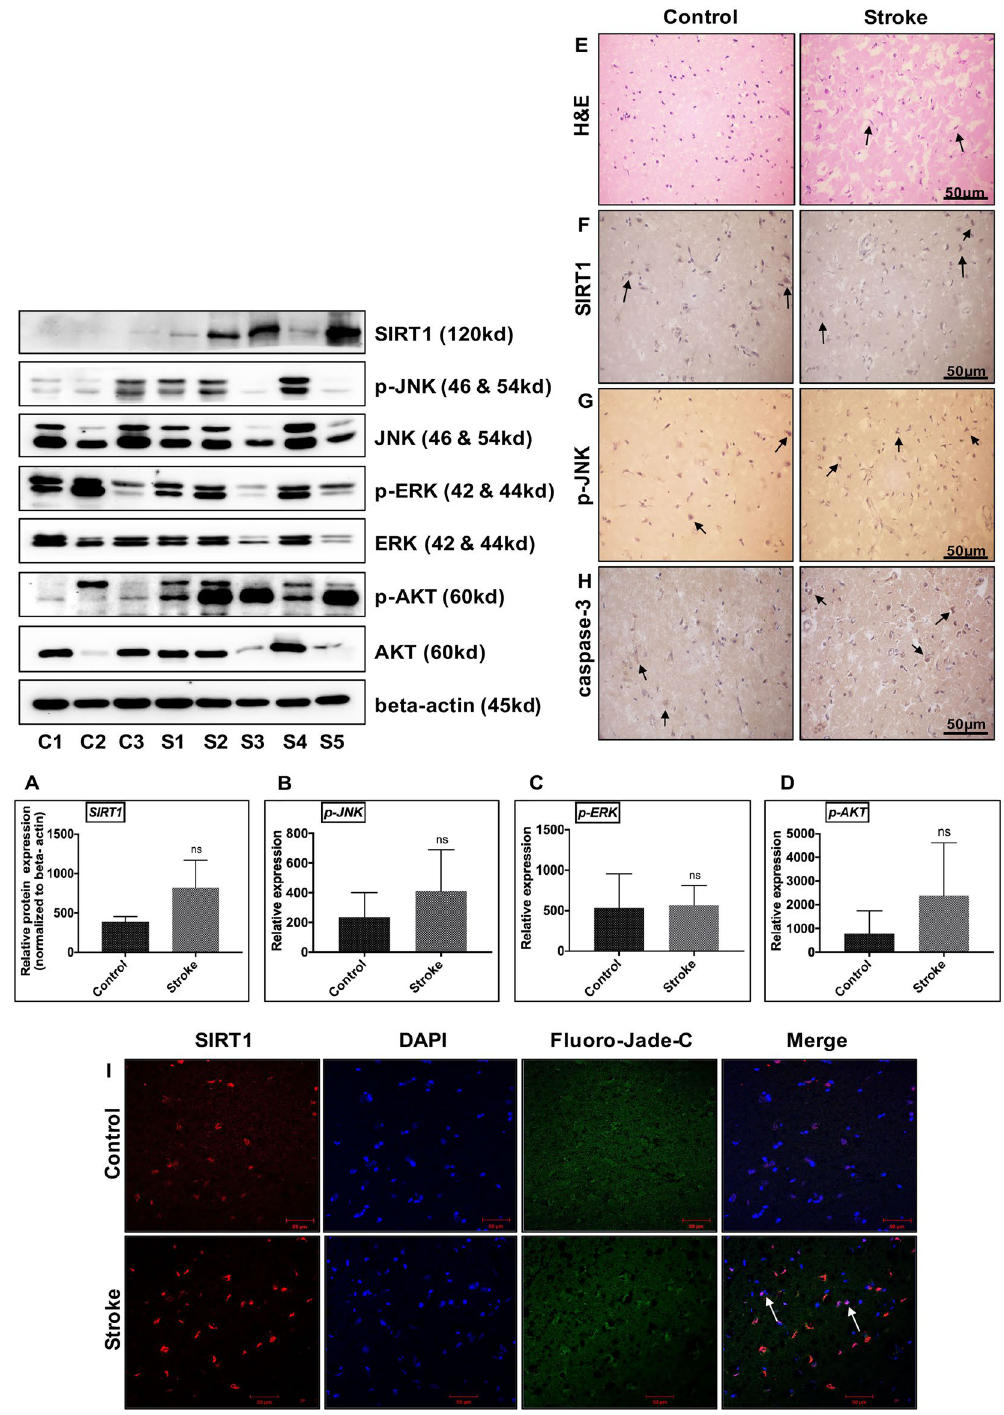
Figure 5. Effect of ischemia on the expression of SIRT1/JNK/ERK/AKT signaling pathway in Post-mortem human brain tissue. An equal amount of total protein sample (50 μg) from Control (n = 3) and Stroke brain (n = 5) were probed by western blots to analyze the expression of SIRT1 and phosphorylation status of p-JNK, p-ERK, and p-AKT. Respective total proteins and beta-actin were served as the loading control (p-JNK, p-ERK, and p-AKT), while SIRT1 was normalized to beta-actin. (A–D) represents an increase in SIRT1, p-JNK, p-ERK, and p-AKT protein expression in human stroke brain compared to respective healthy control. Data represented as mean ± SD. *p < 0.05 versus control brain. Human control (n = 3), as well as stroke brains (n = 4), were paraffin embedded and sectioned into 5-10 μm thick slices. (E) Histopathological changes were observed using H&E staining (magnification ×400; Scale Bar—50 μm). (F,G,H) immunoreactivity of SIRT1, p-JNK, and caspase-3 in control and stroke human brain. Black arrow represents changes in immunoreactivity from respective group. Hematoxylin counterstain used for visualization of neuron nucleus. Immunoreactivity for SIRT1, p-JNK, and caspase-3 was depicted in brown (DAB) (magnification ×400; Scale Bar—50 μm). (I) Triple immunofluorescence labeling was used to probe for SIRT1 (Red), DAPI (Blue), and Fluoro Jade-C (Green) in control (n = 3) and stroke human brains (n = 4). The representative image has shown the number of Fluoro Jade-C positive cells that co-localized with SIRT1 in stroke brain compared to control (white arrows), (Scale Bar—50